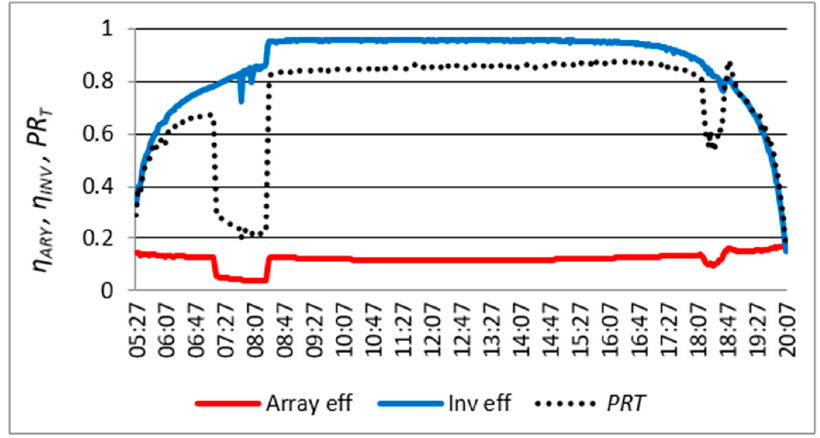
Figure 7. The variation of inverter output power in regard to ambient conditions: ( a ) dependency of irradiation; ( b ) dependency on the temperature.